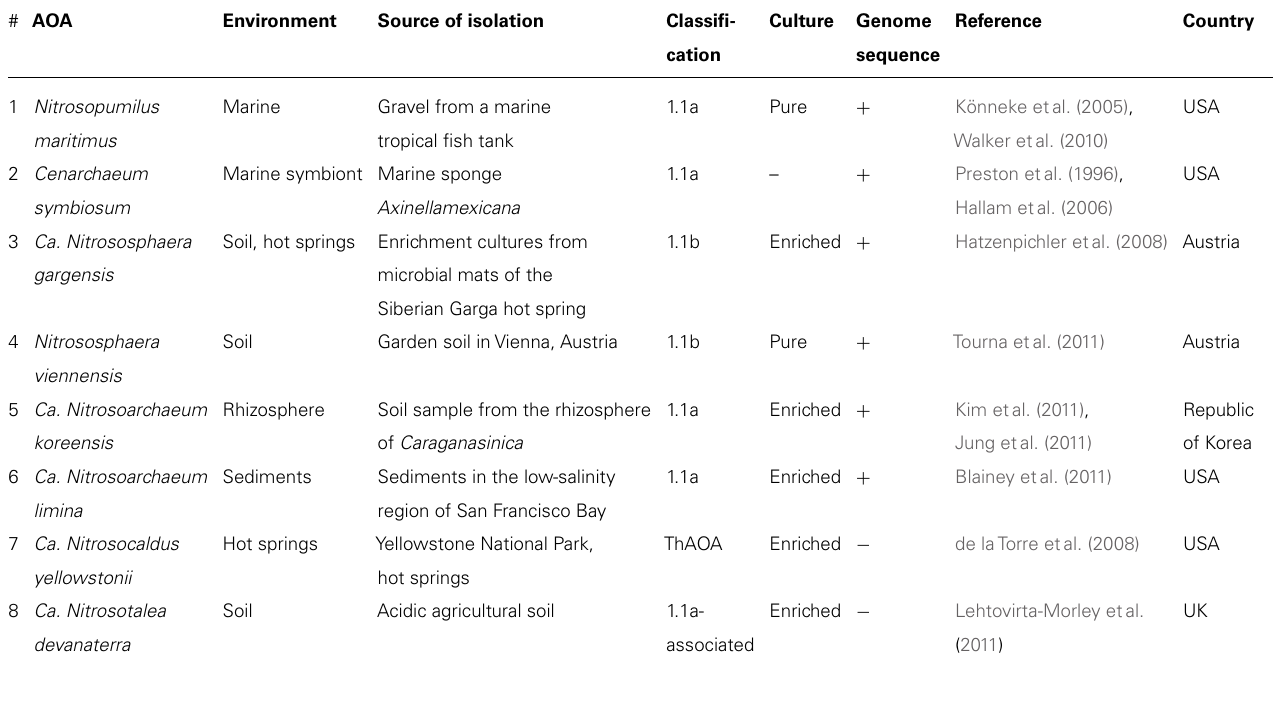
Table 1 |Ammonia-oxidizing archaea isolated from different